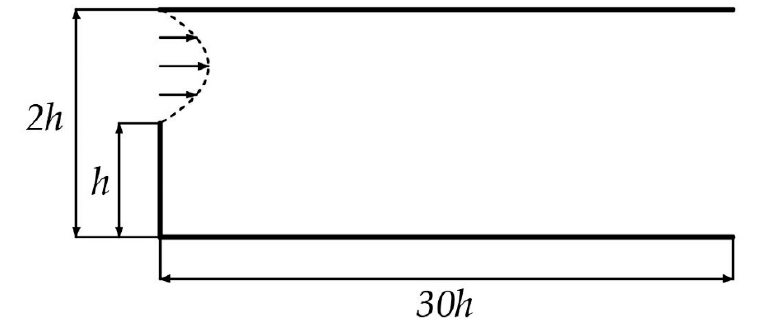
Figure 11. Schematic diagram of calculation region of backward-facing step flow field.